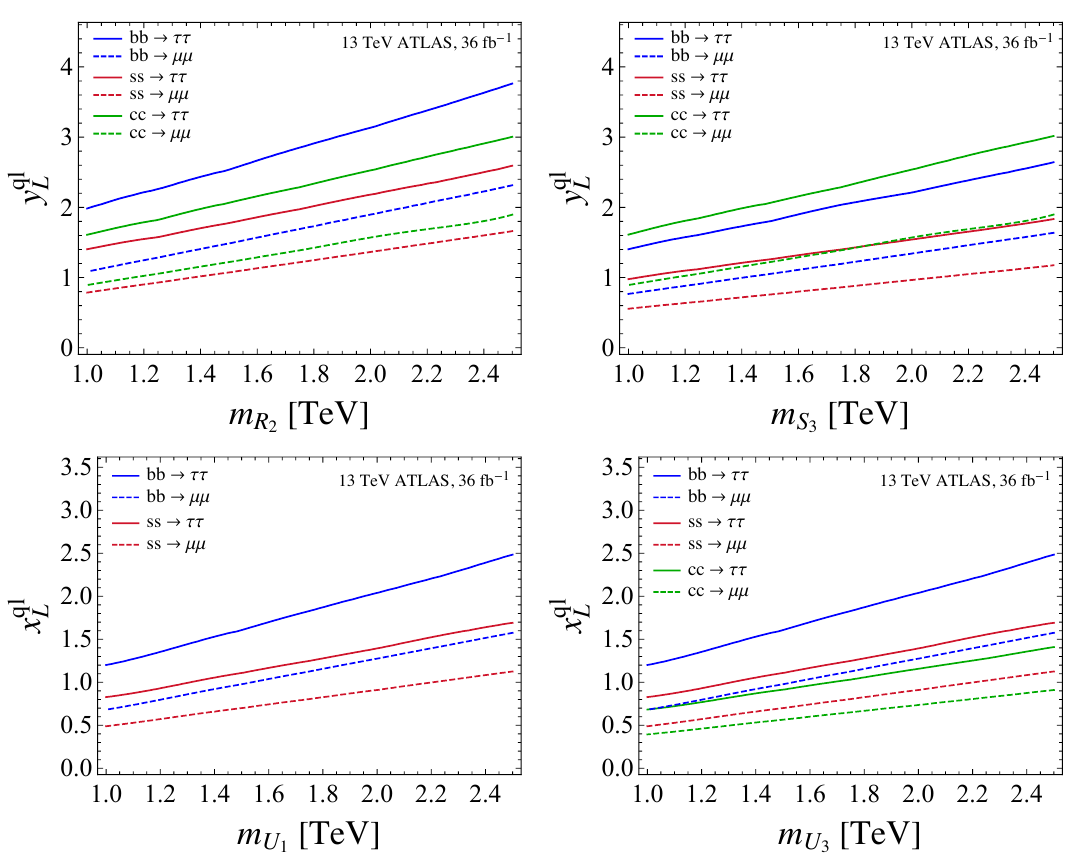
Figure 4: The top panel (lower panel) shows current limits in the coupling vs mass plane for several scalar LQ (vector LQ) models from LHC searches in pp → τ ¯ τ , µ ¯ µ high- p tails at 13 TeV with 36 fb − 1 of data. The solid and dashed lines represent lim- T its from di-tau and di-muon searches, respectively, for different initial quarks while turning one scalar (vector) LQ coupling y ql ( x ql ) at a L L